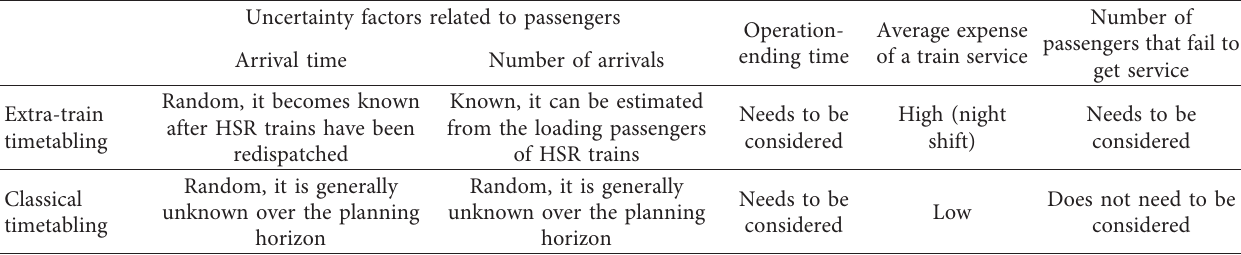
Table 1: Comparison of classical and extra-train timetabling